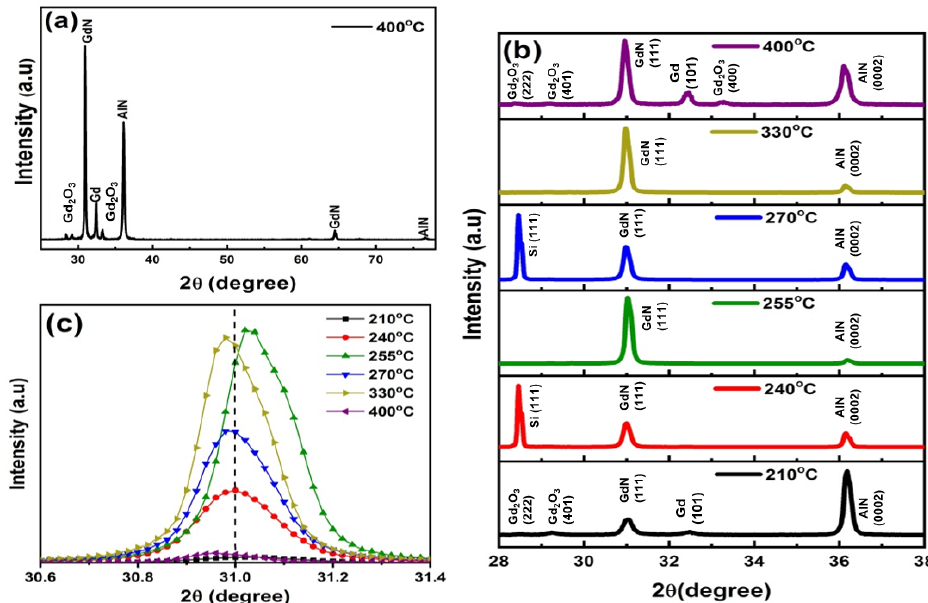
Figure 4. XRD pattern of ( a ) 400 °C annealed Gd film grown on AlN (0001) sample, ( b ) comparison of Gd films grown on AlN (0001) samples annealed in different temperature 210 °C, 240 °C, 255 °C, 270 °C, 330 °C and 400 °C, ( c ) showing the shift in the samples at 2θ =